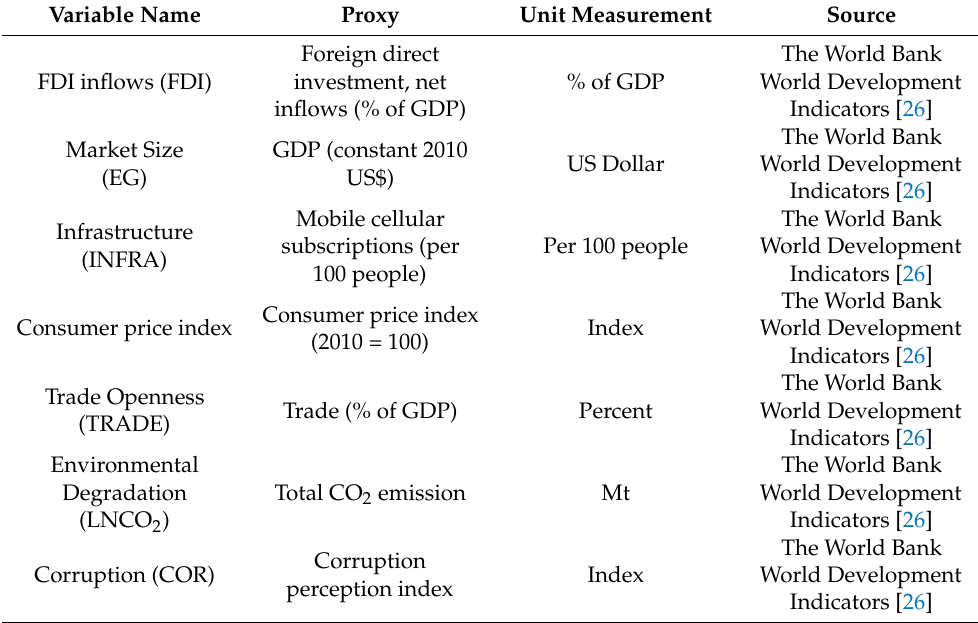
Table 1. Variable